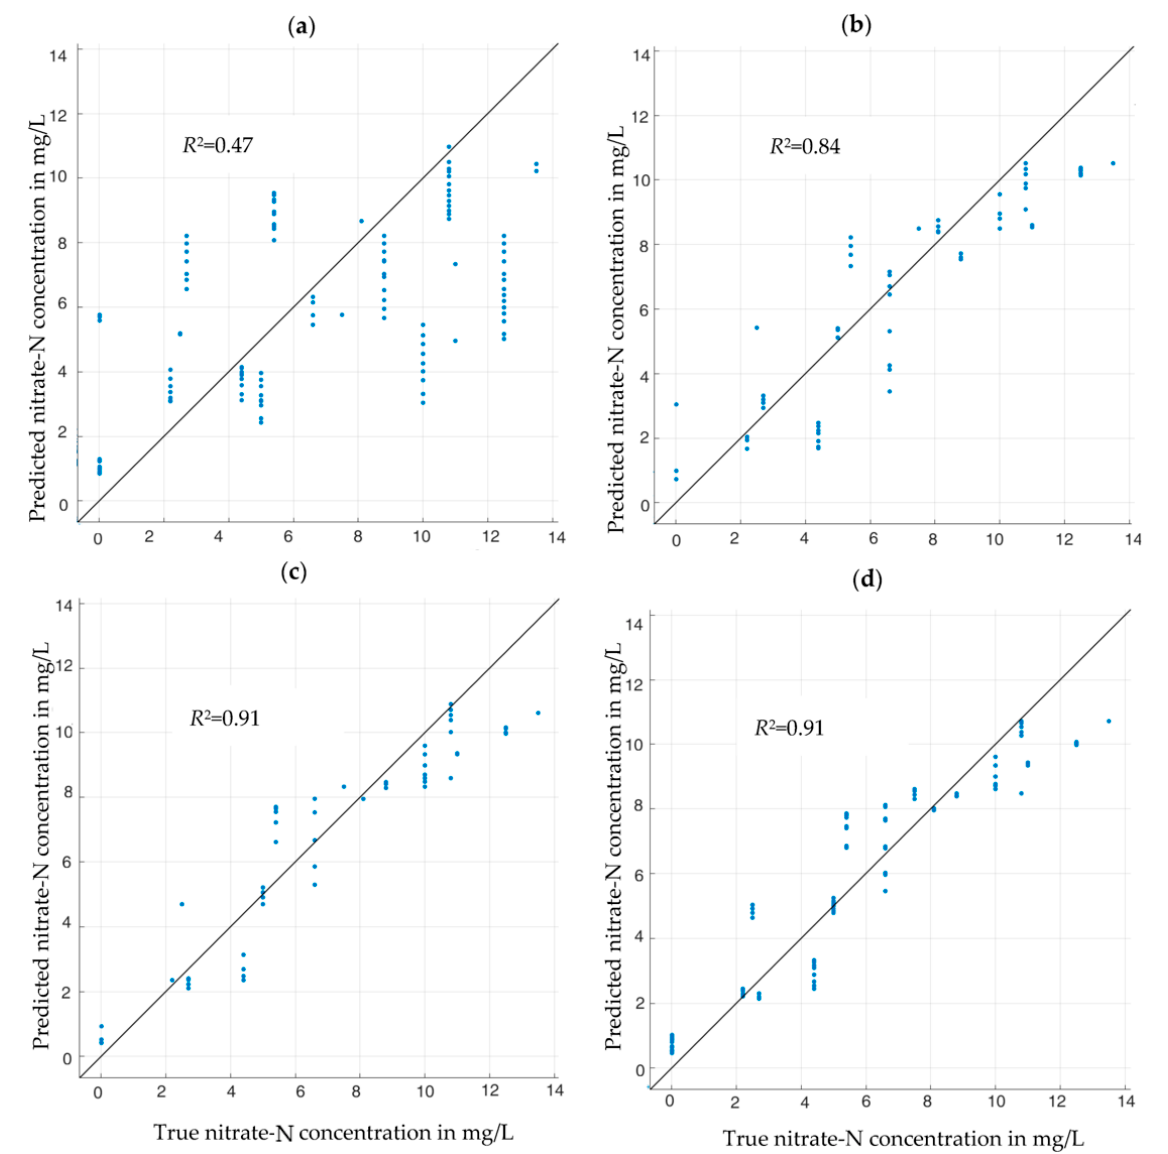
Figure 6. Nitrate-N concentrations predicted by RF-built regression models from measured impedance spectra of synthetic soil samples plus selected other physical variables. ( a ) Results based on the conductance spectrum G as feature. ( b ) Results with features G and θ w . ( c ) Results with features G , θ w , and ρ b . ( d ) Results with features G , θ w , ρ b , and B . Blue dots: estimation results for each of the 360 validation data sets. Straight lines: goal (predicted value = actual value). The R 2 values shown in each chart are the coefficients of determination.